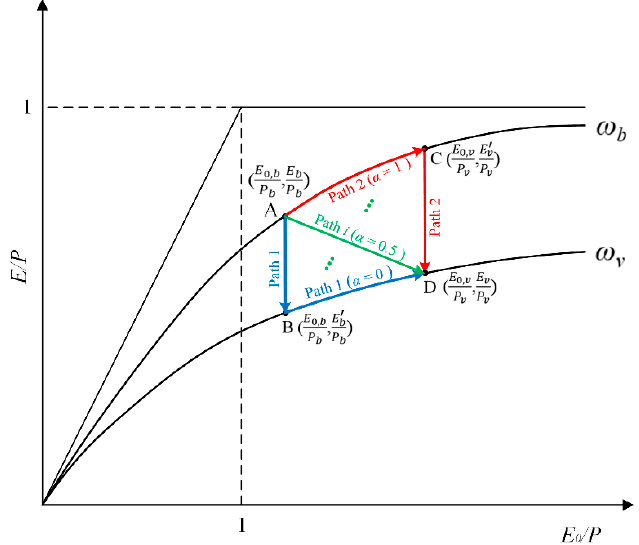
Figure 1. Schematic diagram of Budyko curves with precipitation P , evapotranspiration E , potential evapotranspiration E 0 , catchment characteristic parameter ω , subscript b being baseline period, and v being variation period. E (cid:48) and E (cid:48) v are a ff ected by land use / cover change (LUCC) and climate change, respectively.